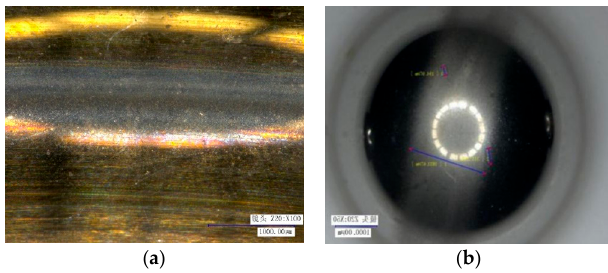
Figure 2. Damage elements of bearings. ( a ) The scratched inner ring. ( b ) The scratched ball.